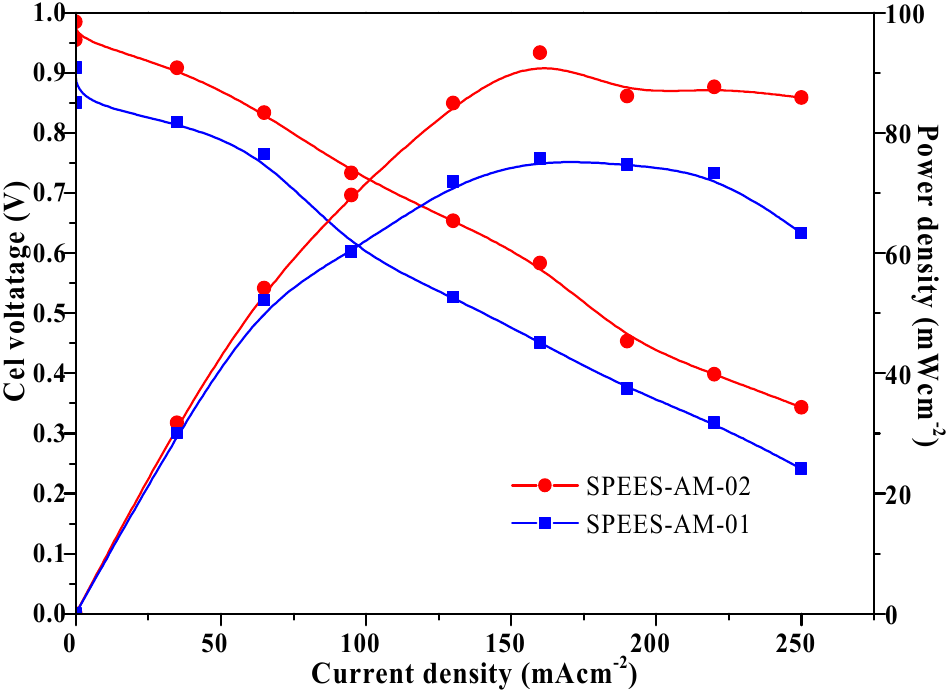
Figure 12. Fuel cell performance of SPEES-AM membranes in H 2 / O 2 single cell PEMFC test at 50 °C (under 15% RH).